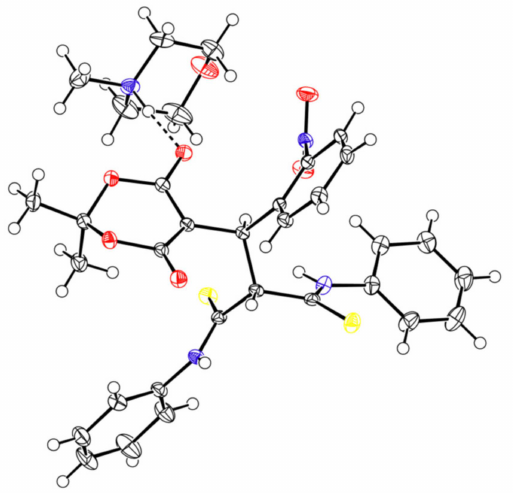
Figure 2. ORTEP drawing of X-ray structure for N-methylmorpholinium 2,2-dimethyl-5-(1-(2- nitrophenyl)-3-(phenylamino)-2-(N-phenylthiocarbamoyl)-3-thioxopropyl)-4-oxo-4H-1,3-dioxin-6- olate 15b (CCDC deposition number 2218133